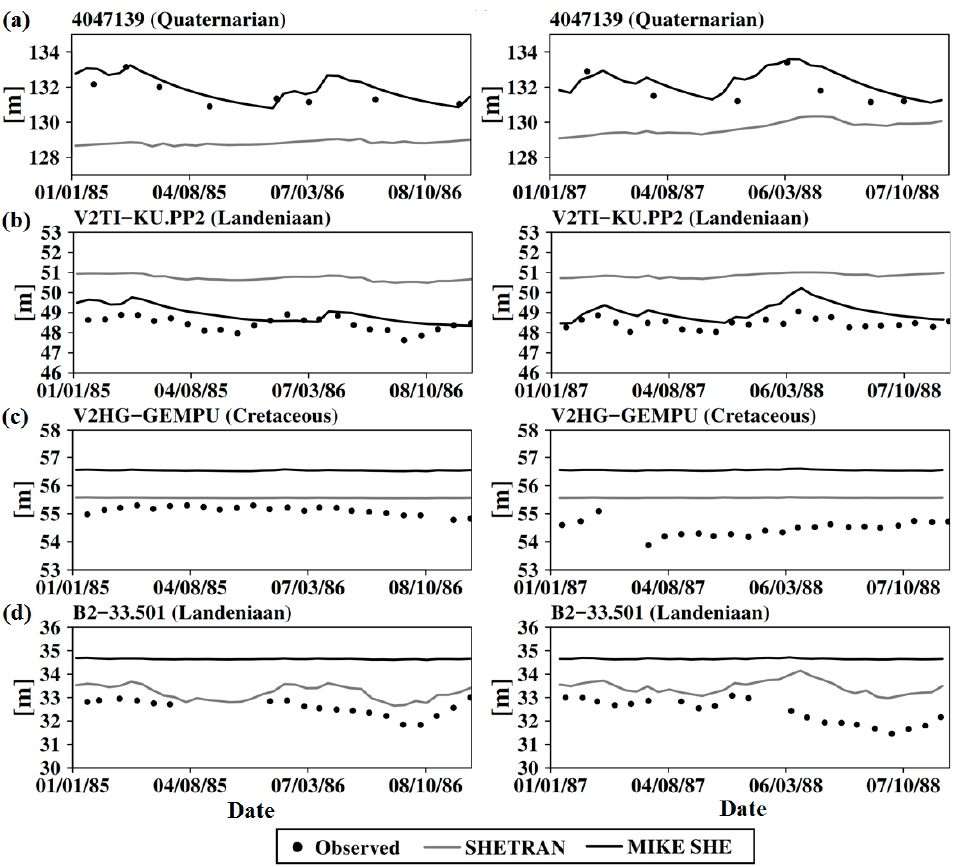
Figure 8. Observed and simulated piezometric levels for some selected wells included in the analysis throughout calibration ( left column ) and validation ( right column ) periods. Screens of wells are located in the geological layers: ( a ) Quaternarian; ( b ) Landeniaan; ( c ) Cretaceous; and ( d ) Landeniaan.